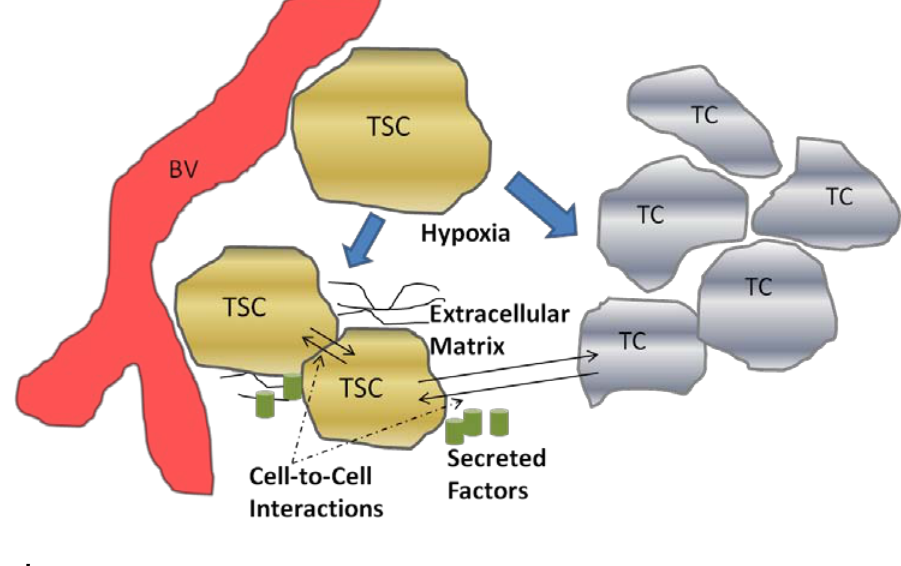
Figure 2. Tumor stem cell (TSC) niche. TSCs give rise to tumor cells (TC) and other TSCs. TSCs are thought to undergo self-renewal near blood vessels (BV) in the TSC niche. Multiple factors contribute to the microenvironment including hypoxia, the extracellular matrix, cell-to-cell interactions, secreted factors and signals, and the tissue makeup